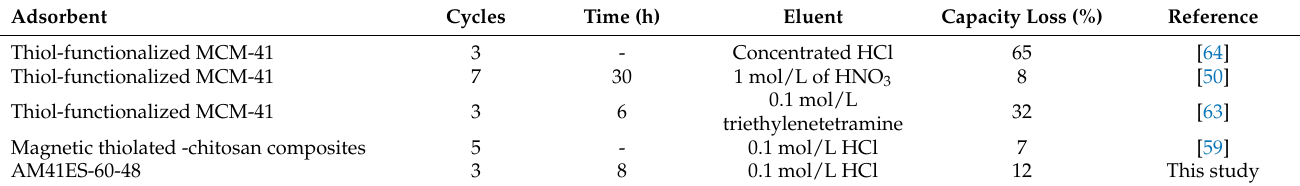
Table 10. Comparison of regeneration capacity of thiol-functionalized adsorbents.